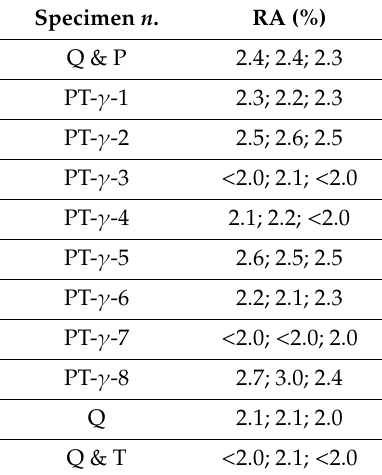
Table 3. Retained austenite content as a function of performed heat treatments (three measures for each specimen are